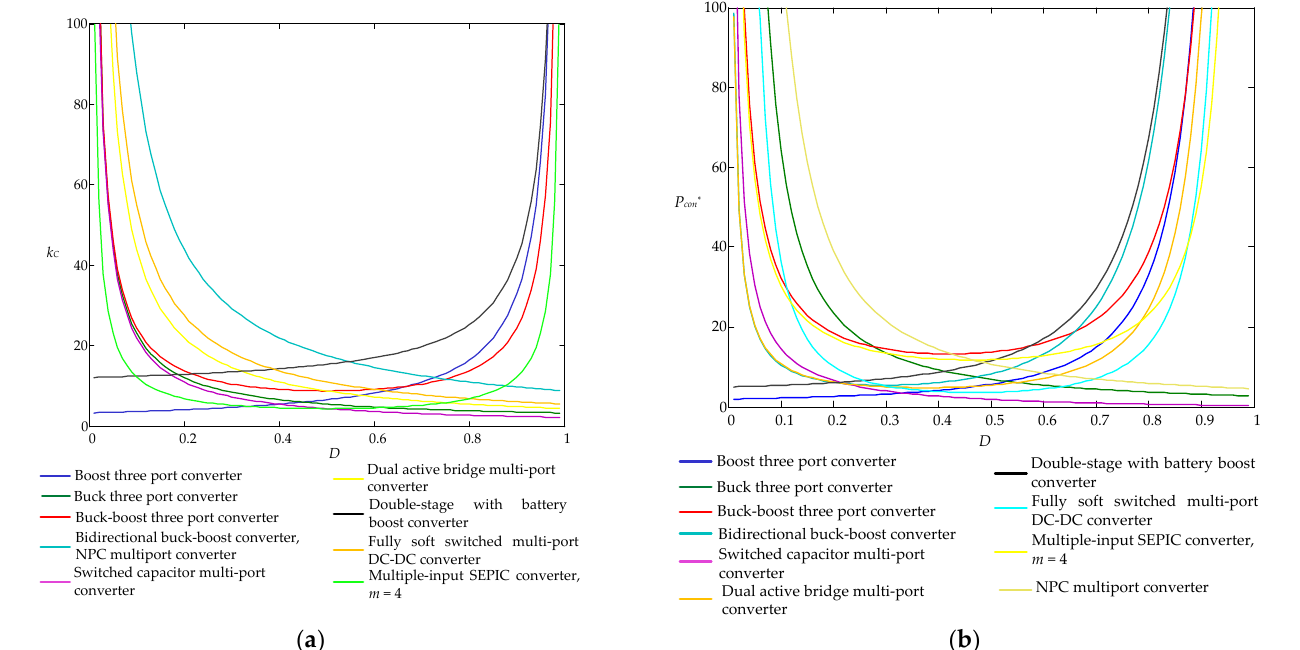
Figure 21. Hybrid converter parameters: ( a ) cost factor k C ; ( b ) normalized power loss P con * .